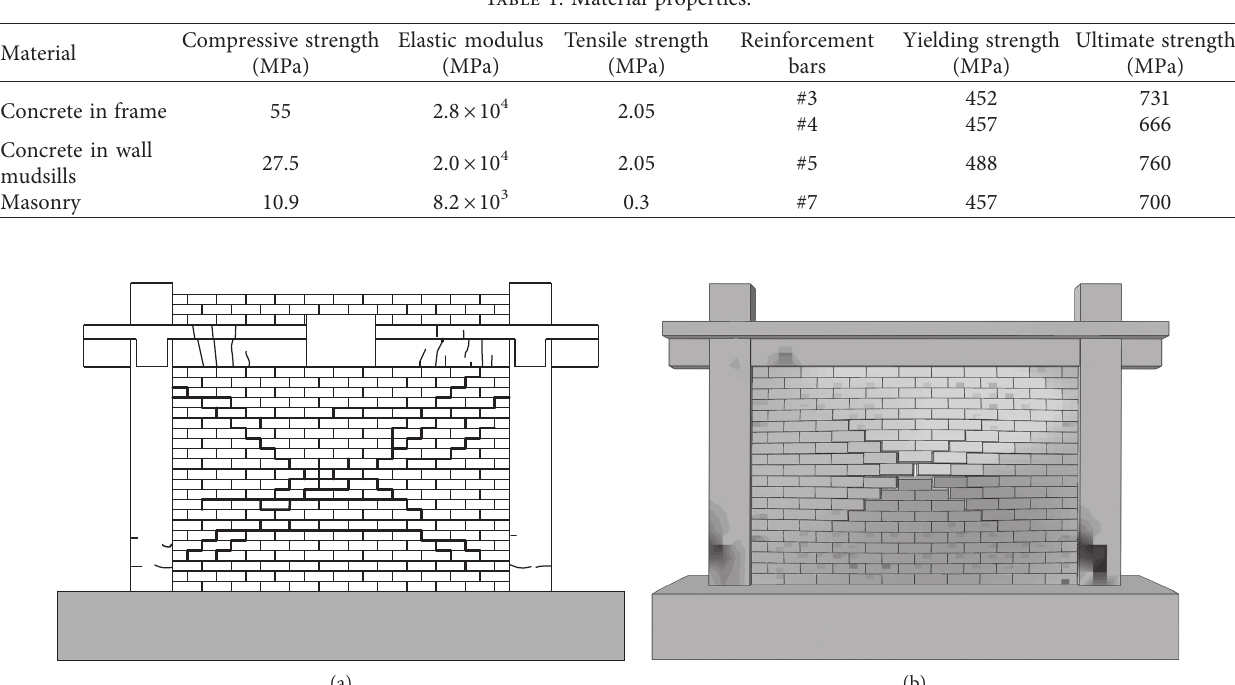
Figure 2: Geometry and reinforcement information (mm). Table 1: Material properties.